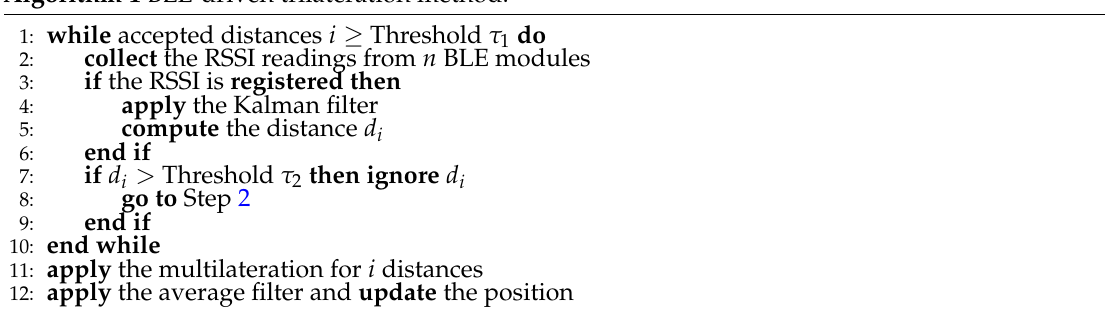
Algorithm 1 BLE-driven trilateration